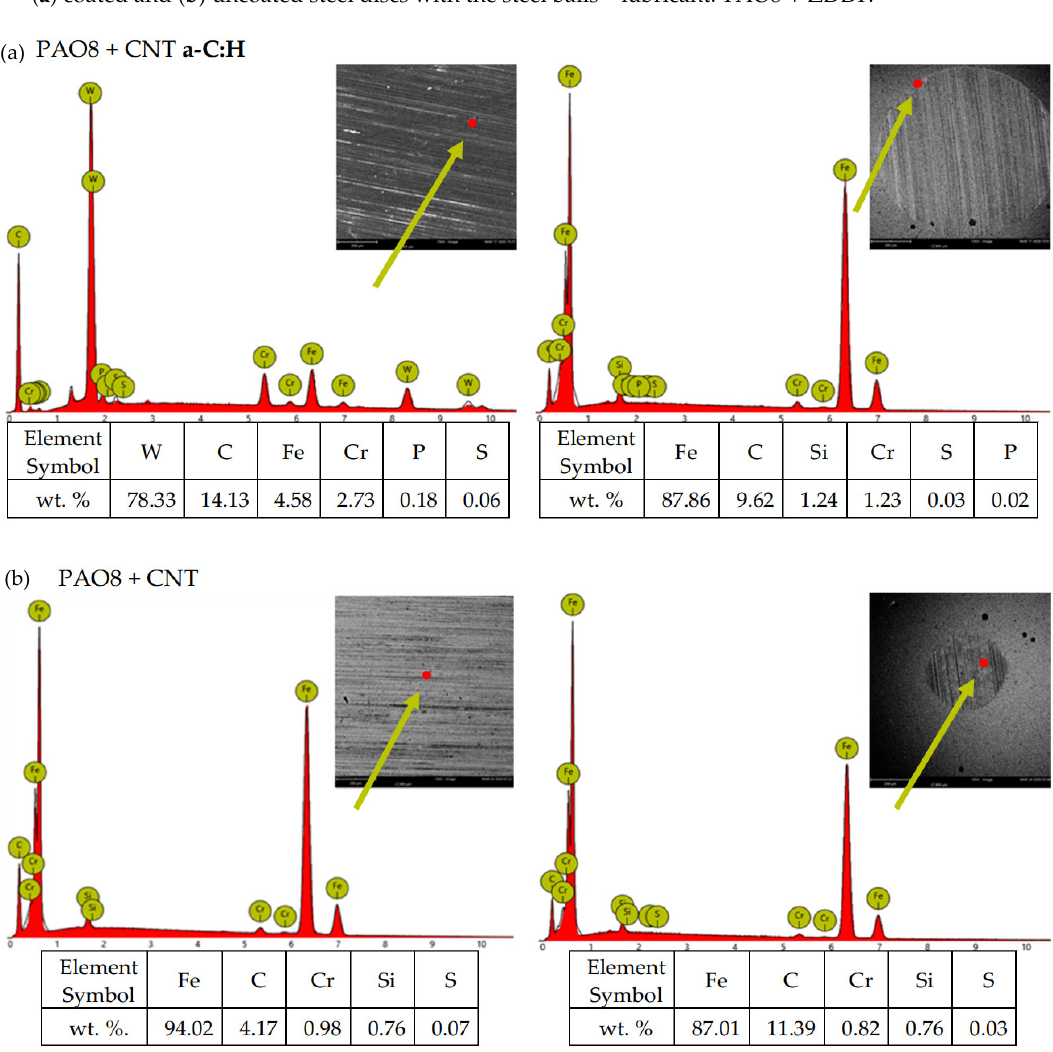
Figure 12. EDS patterns for di ff erent points of the wear track resulting from the sliding contact of the ( a ) coated and ( b ) uncoated steel discs with the steel balls—lubricant: PAO8 +